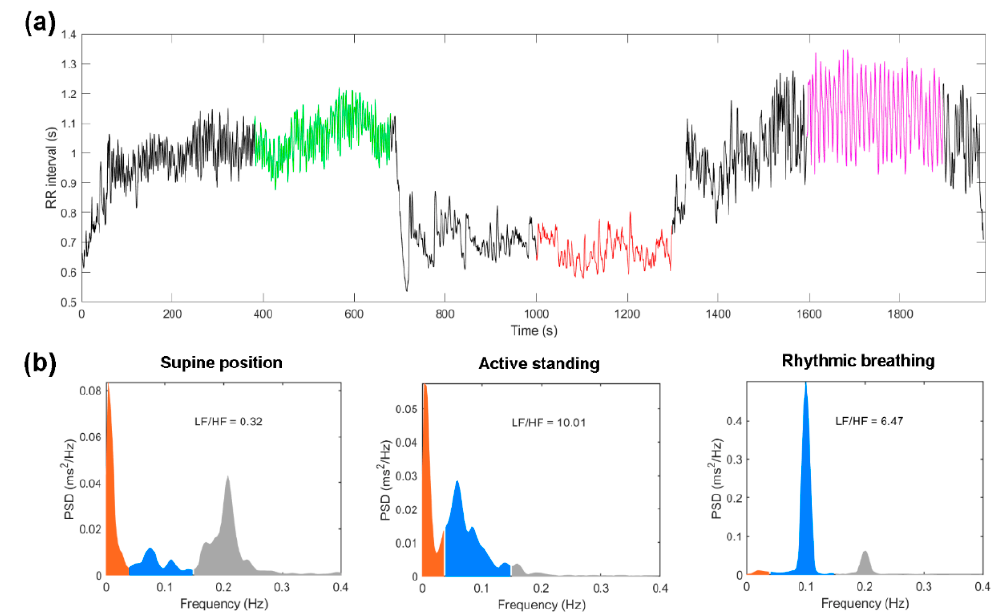
Figure 2. Example of HRV analysis from a healthy subject. ( a ) Time series obtained from the entire recording protocol with selected 5-min segments that we used in the HRV analysis are indicated with color: supine position (green), active standing (red), and rhythmic breathing (magenta). ( b ) Power spectrum density (PSD) from the selected segments: very low-frequency (orange), low-frequency (blue), high-frequency (grey), (LF/HF = ratio of low-frequency band power with respect to high frequency band power).